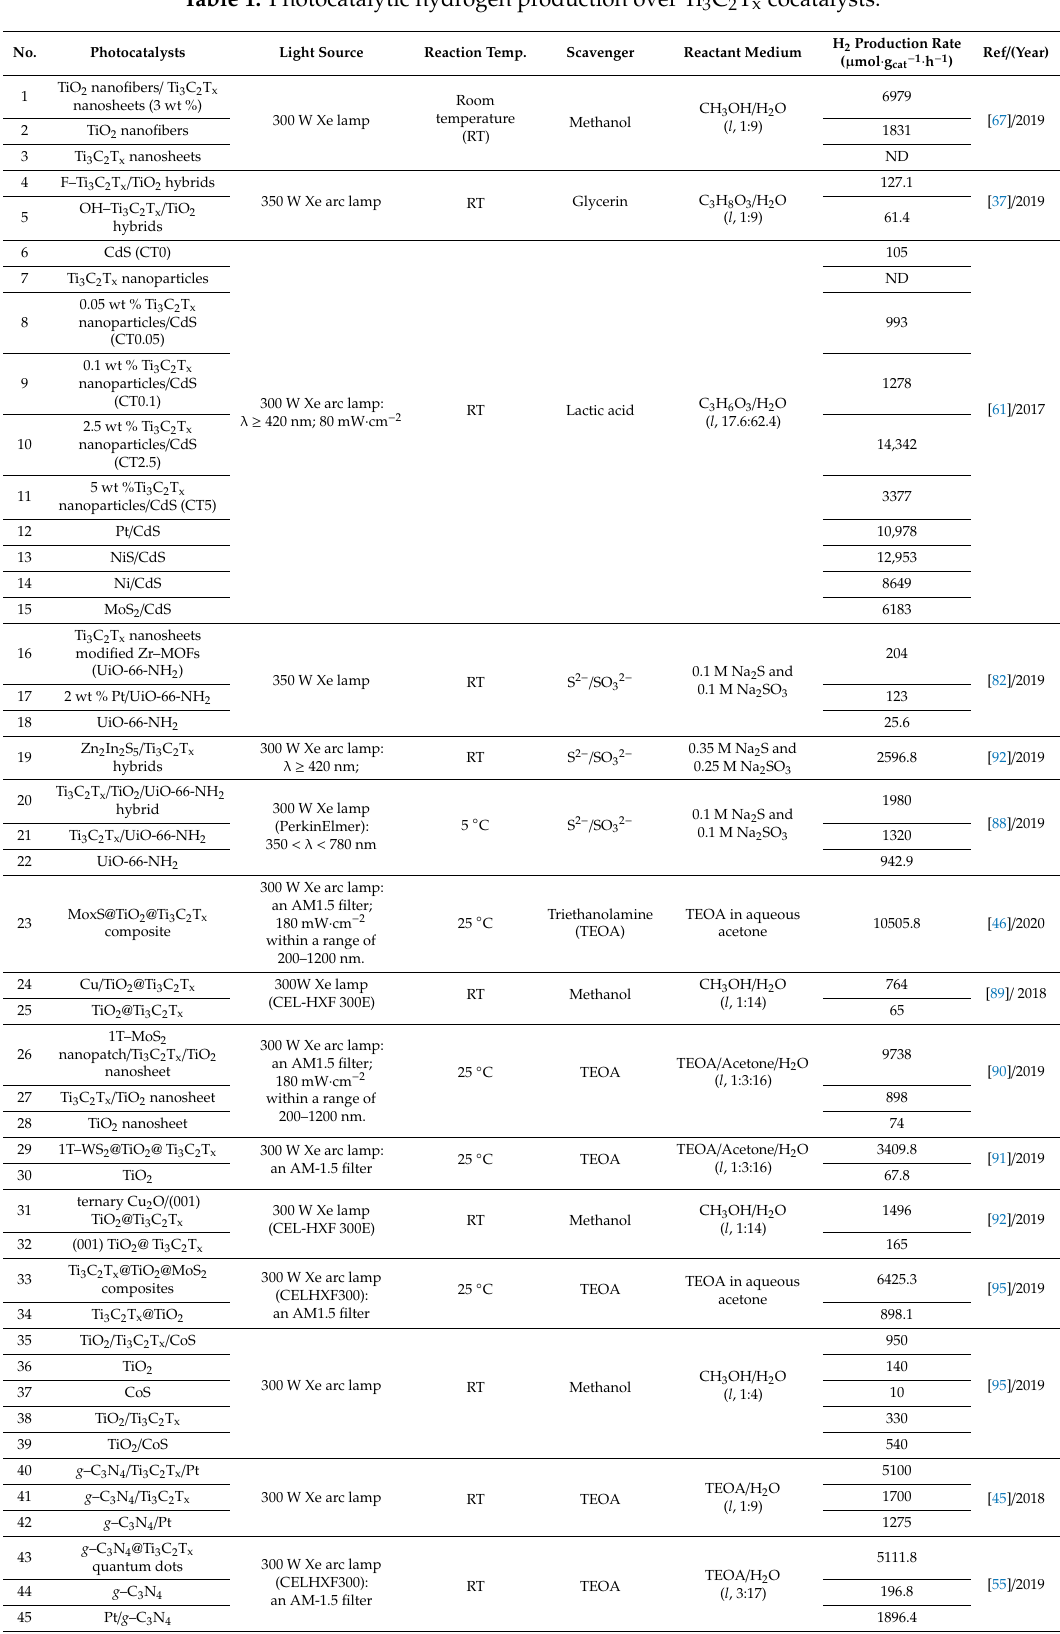
Table 1. Photocatalytic hydrogen production over Ti 3 C 2 T x